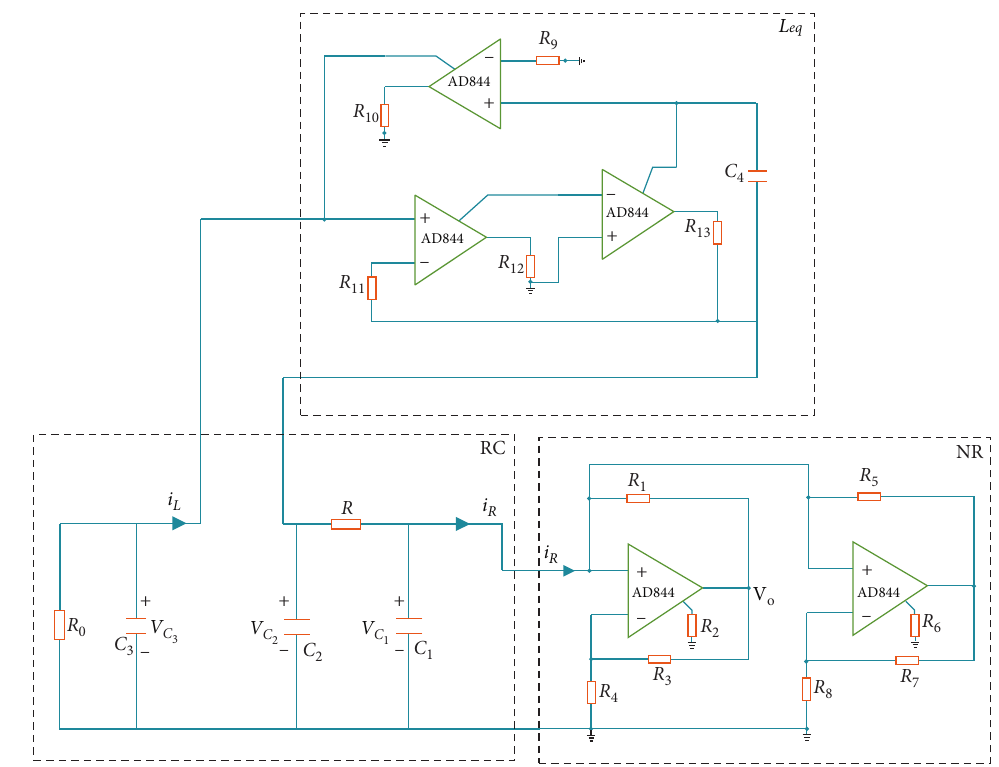
Figure 11: Inductorless modified Chua’s chaotic circuit realized by CCII. Table 2: Values of components used in the modified Chua’s chaotic